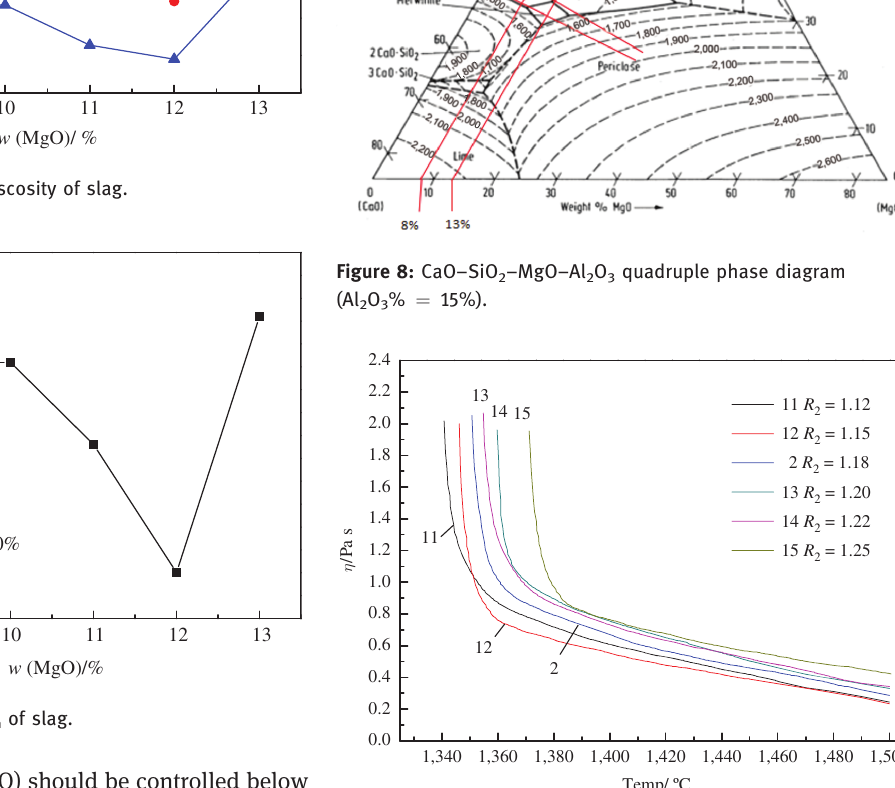
Figure 9: Effect of temperature on viscosity of